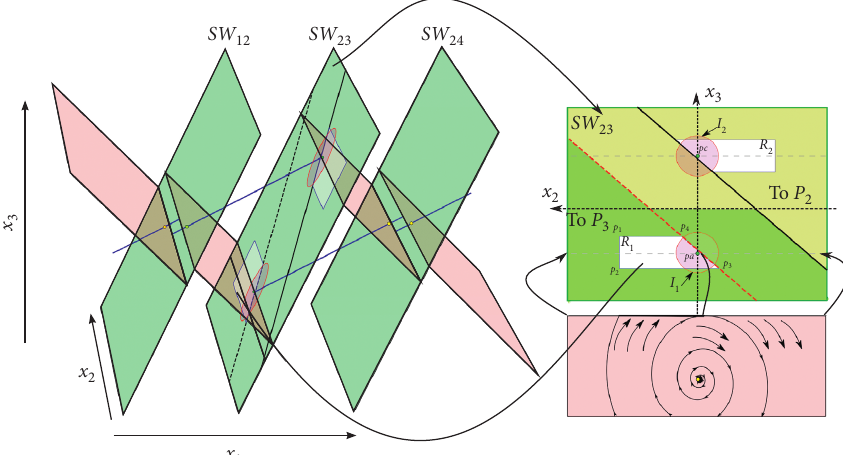
Figure 6: Projection of the manifolds on (a) ( x blue and red solid lines, respectively, the switching surfaces with green lines.